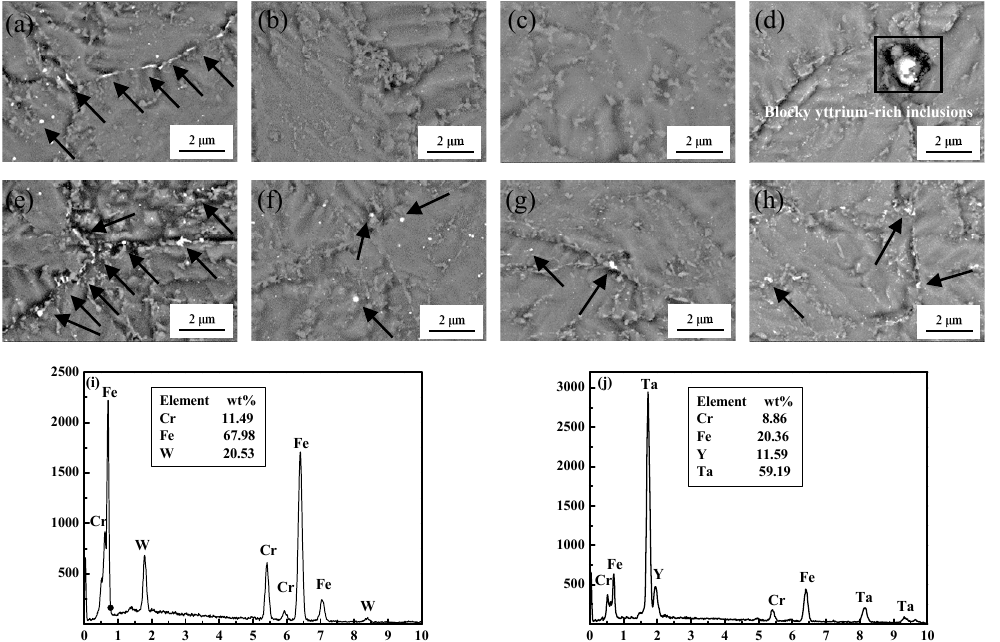
Figure 3. Back-scattered electron (BSE) images of aged samples: ( a – d ) 1500 h, ( e – h ) 3000 h, ( a , e ) 0Y, ( b , f ) 6Y, ( c , g ) 36Y, and ( d , h ) 71Y. ( i , j ) EDS spectrum of Laves phase ( i ) and Y-rich inclusions ( j ).